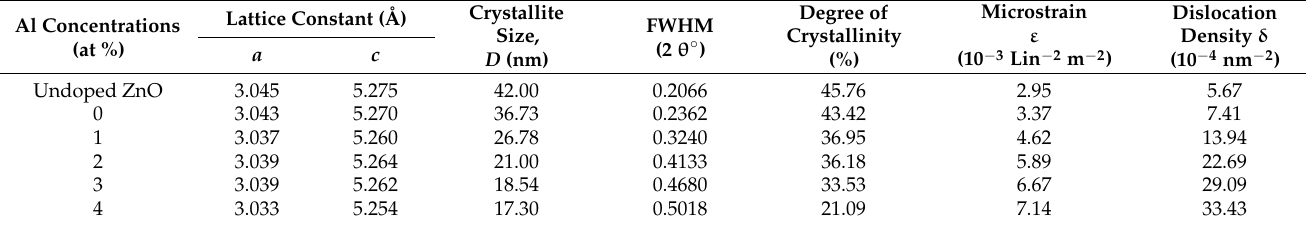
Table 2. Structural properties of (Gd, Al) co-doped ZnO films with variation of the Al concentration. Al Concentrations (at